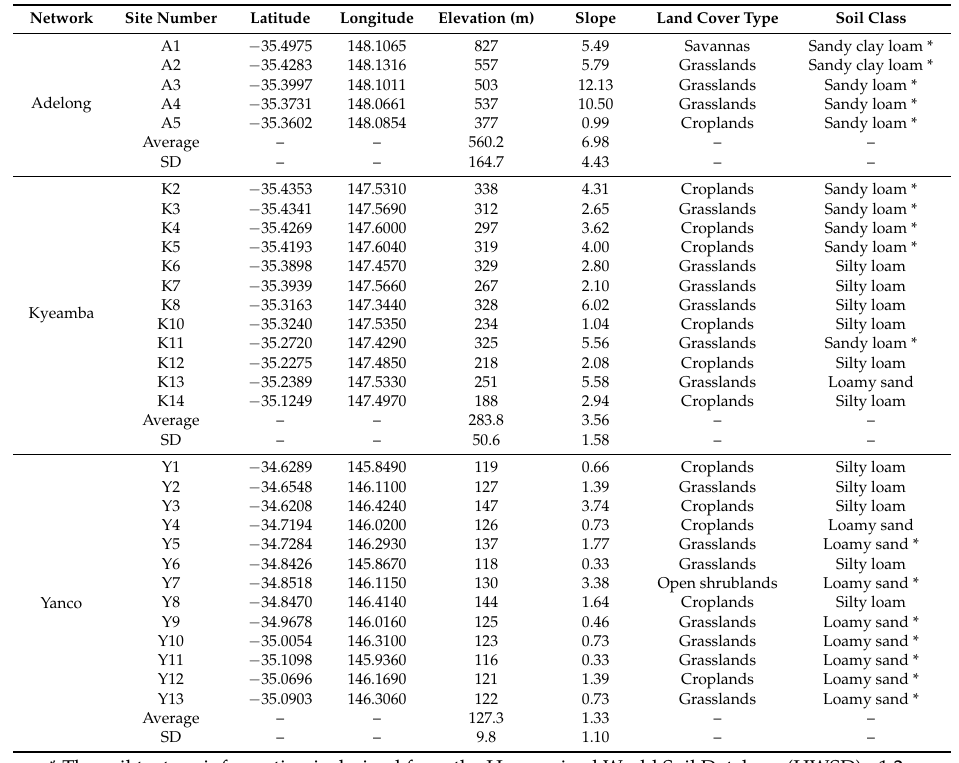
Table 1. The latitudes/longitudes, elevations, slopes, land cover types, and soil classes for sites within the different